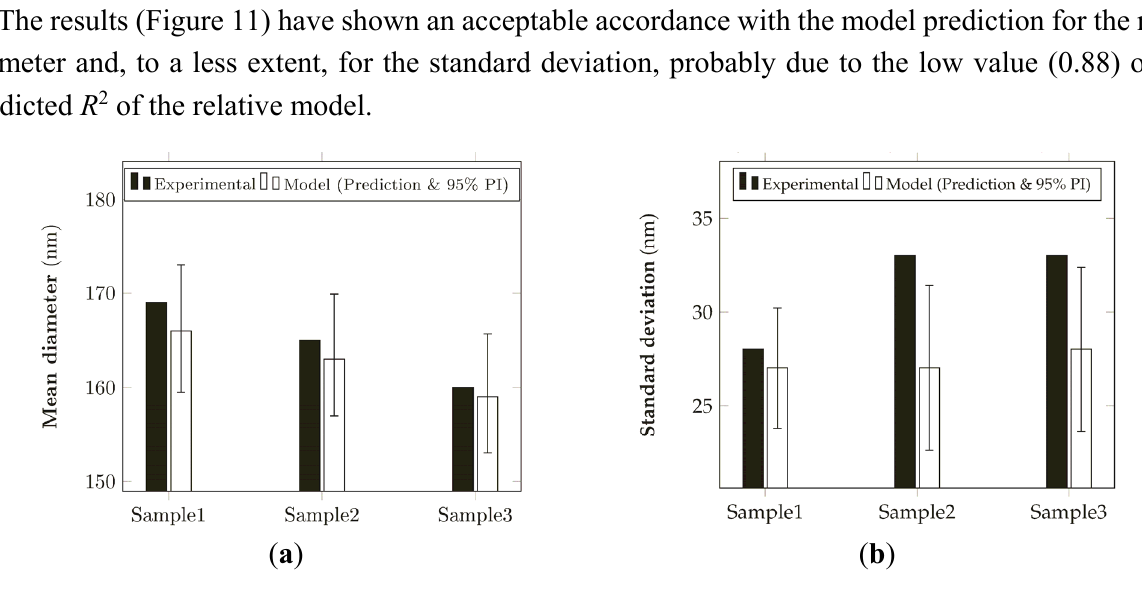
Figure 11. Comparison between the experimental results and the model prediction (prediction and 95% prediction interval) for: ( a ) the mean diameters and ( b ) the standard deviation of electrospun